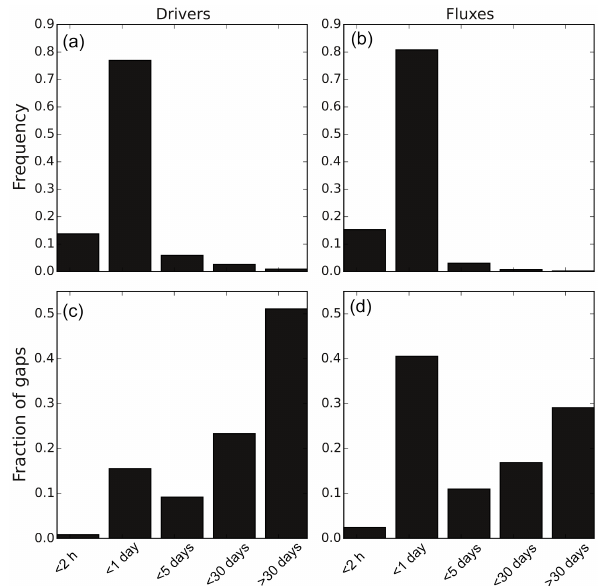
Figure 3. Histograms of gap frequency by duration for (a) drivers and (b) fluxes and histograms of the fraction of total gap length for (c) drivers and (d)